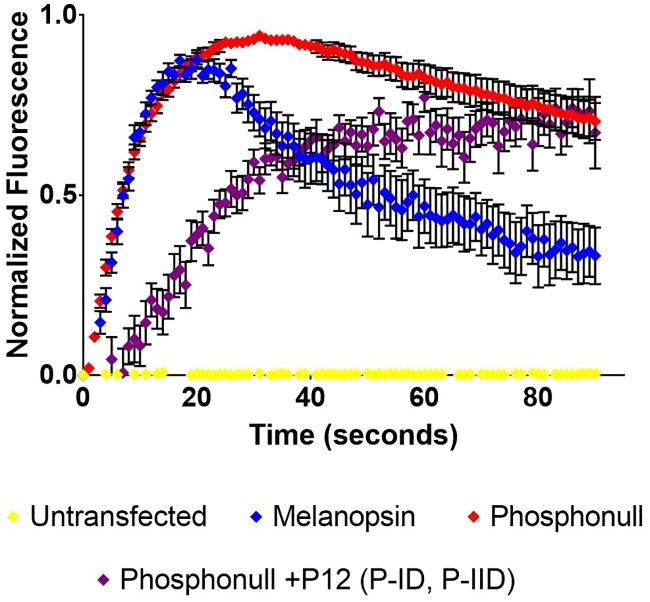
Phospho-mimetic mutation of P-I and P-II in phosphonull melanopsin does not rescue deactivation defect.Phosphonull melanopsin was used to mutate P-I and P-II from alanine to aspartic acid to synthesize the phosphonull +P12 (P-ID, P-IID) mutant. Calcium imaging data show that this phospho-mimetic construct doesn’t reach peak signaling activation in the time span of the assay. Error bars represent the S.E.M. of three independent transfections.